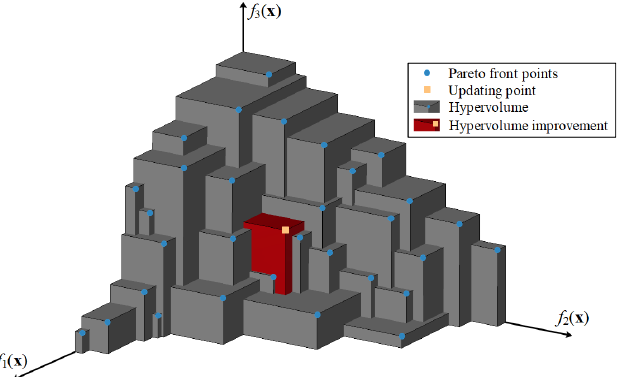
Figure 2. Example of geometry shape of hypervolume and its improvement.